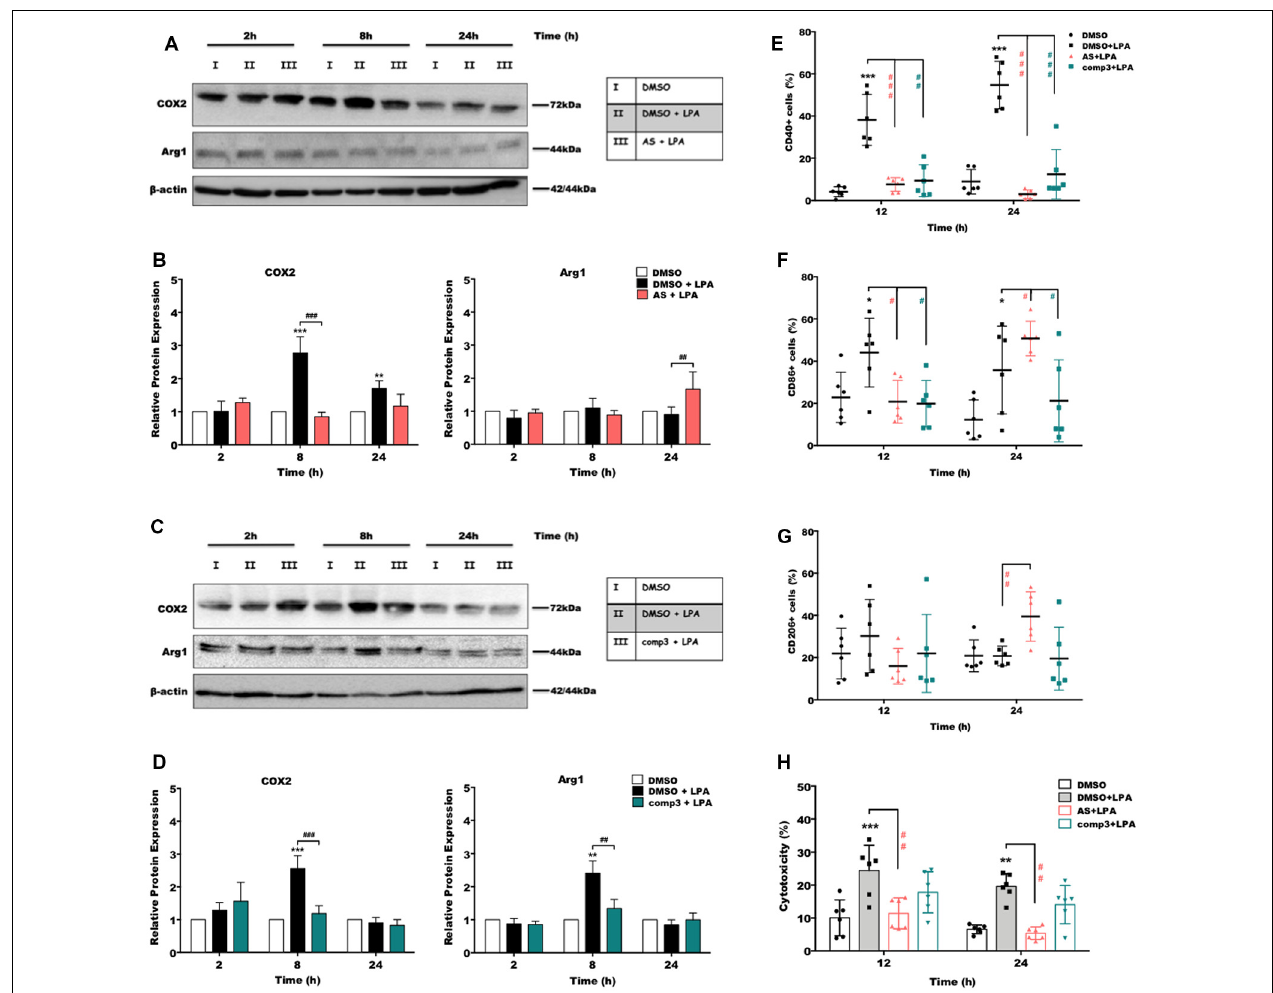
FIGURE 4 | AS2717638 and compound 3 restore a neuroprotective microglial phenotype while only AS2717638 reduces neurotoxicity of microglia-conditioned medium. Serum-starved microglia cells were treated with DMSO, DMSO plus LPA (1 µ M), and LPA plus AS2717638 (0.1 µ M; A ) or compound3 (1 µ M; C ) for 2, 8, and 24 h. Cell lysates were collected and the expression of COX-2 and Arg-1 was monitored by immunoblotting. One representative plot for each protein and the densitometric analysis ( B,D ; mean ± SD) from three independent experiments are presented (mean value of DMSO controls was set to 1). In a parallel experiment, serum-starved (o/n) BV-2 cells were cultivated in the presence of DMSO, DMSO plus LPA (1 µ M) or LPA in the presence of AS2717638 (0.1 µ M) or compound 3 (1 µ M) for the indicated times. Cells were stained with PE-conjugated anti-CD40 (E) , APC-conjugated anti-CD86 (F) or PE-conjugated anti-CD206 (G) antibodies and analyzed using a Guava easyCyte 8 Millipore flow cytometer. Results are shown as mean values ± SD. (H) CATH.a neurons were incubated for 24 h with conditioned media collected from LPA-treated BV-2 cells in the presence or absence of AS2717638 (0.1 µ M) or compound 3 (1 µ M) for 12 and 24 h. The LDH levels were detected and cytotoxicity was calculated according to the manufacturer’s instructions ( ∗ p < 0.05; ∗∗ p < 0.01; ∗∗∗ p < 0.001 compared to DMSO-treated cells; # p < 0.05; ## p < 0.01; ### p < 0.001 each inhibitor compared to LPA-treated cells; one-way ANOVA with Bonferroni